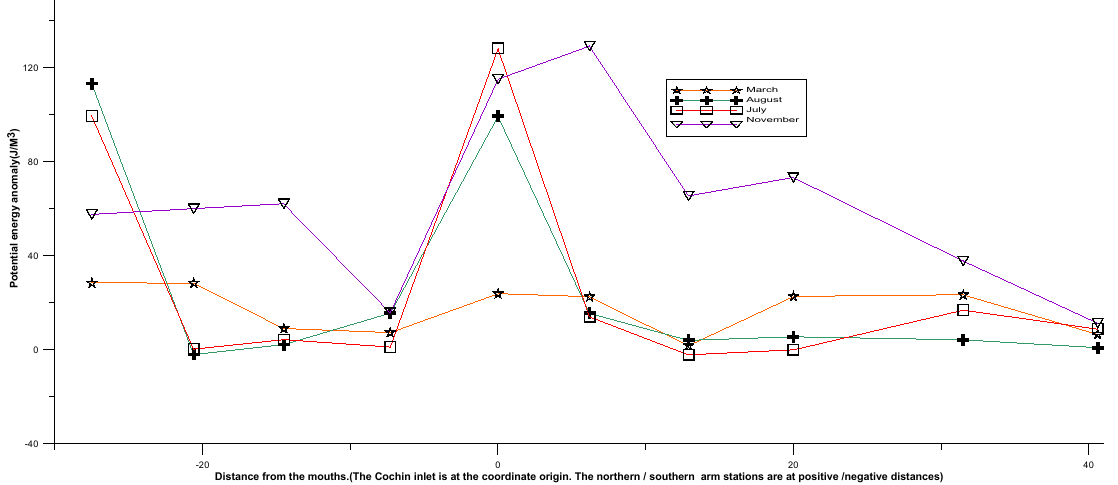
Fig. 9. Spatial variation in the potential energy anomaly (the months are characterised by southwest monsoon (July–August), northeast monsoon (November) and dry period